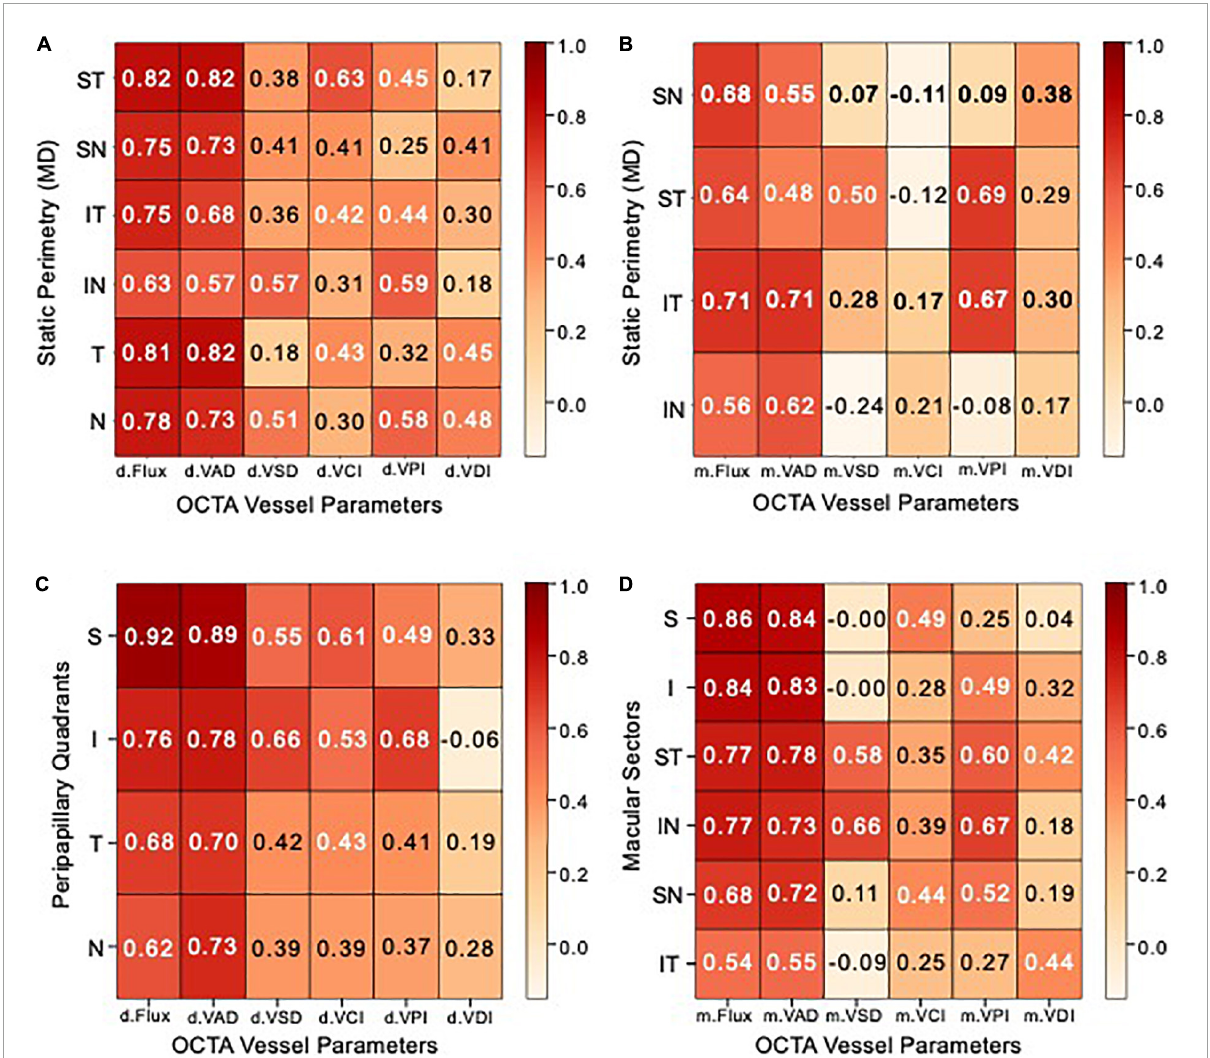
FIGURE5 Peripapillary and macular heatmaps showing Spearman correlation matrices. (A,B) Heatmap showing Spearman correlation coefficients between optical coherence tomography angiography (OCTA) vessel parameter measurements (X–AXIS) and static perimetry mean deviation (Y–AXIS) of (A) peripapillary Garway-Heath sectors, (B) macular cross-quadrants. (C,D) Heatmap showing Spearman correlation coefficients between OCTA vessel parameters (X–AXIS) and optical coherence tomography (OCT) measurements (Y–AXIS) of (C) peripapillary RNFL quadrants, (D) macular ganglion cell complex (GCC) sectors. Correlation coefficients between 0.7–1, 0.3–0.7, and 0–0.3 are rated as high, moderate, and low,